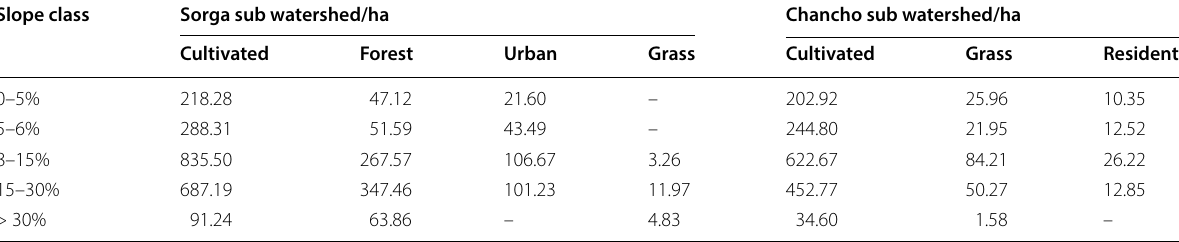
Table 1 Slope gradient share of each land use/cover types in hectare Slope